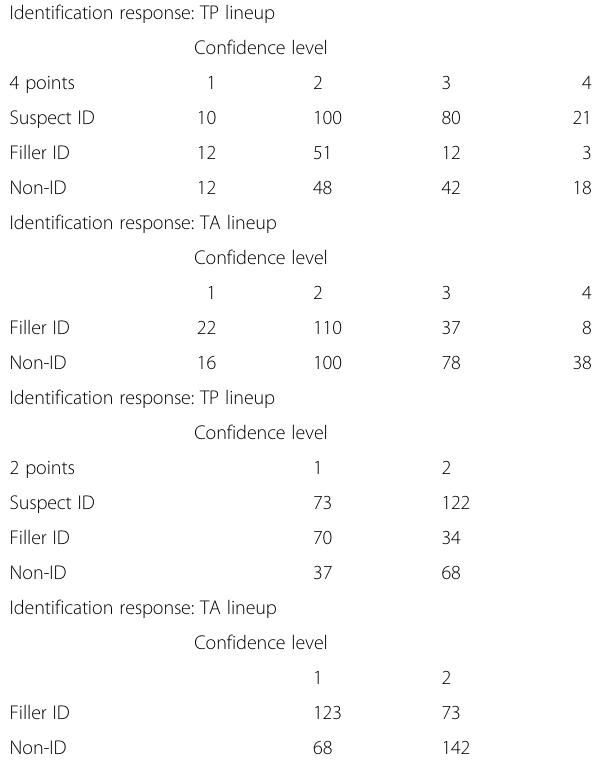
Table 2 Frequencies of identification responses at each confidence level for target-present (TP) and target-absent (TA) lineups